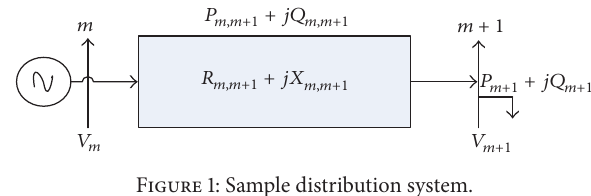
Figure 1: Sample distribution